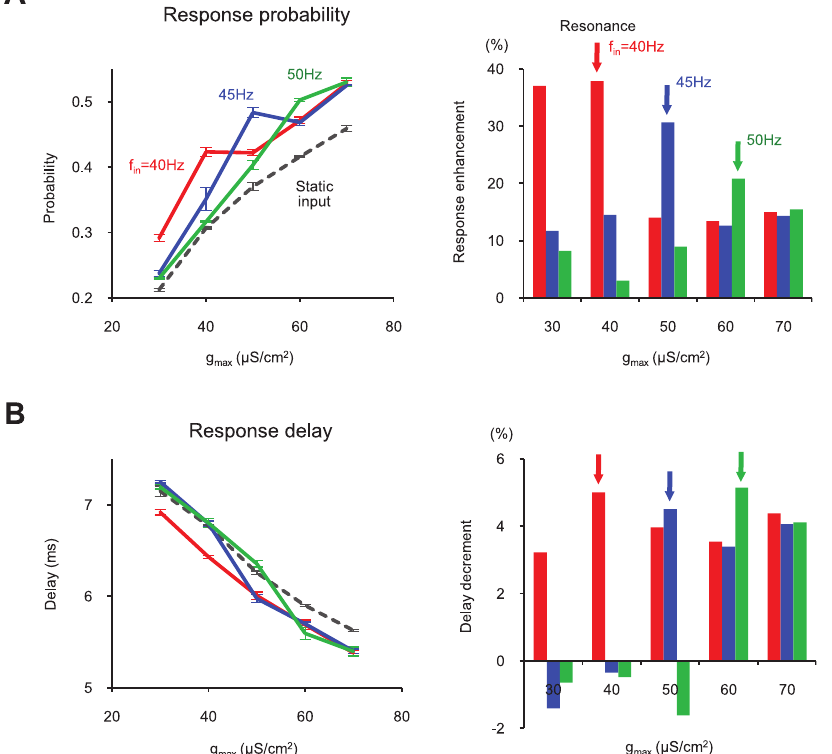
Figure 4. Gamma oscillation resonance tuning by synaptic plasticity. (A) Response probability modulation by frequency-dependent gamma resonance. Response enhancement was defined as the difference between the responses to static input and to other inputs. Note that the peak value of modulation (resonance point) varies by input frequency. (B) Response delay modulation. Negative values in response delay decrement mean increased